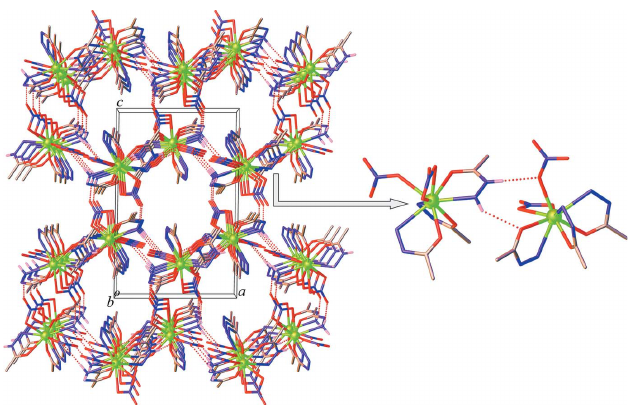
Figure 5 The three-dimensional hydrogen-bonded network in 1 (hydrogen atoms, except those forming hydrogen bonds, are omitted for clarity).